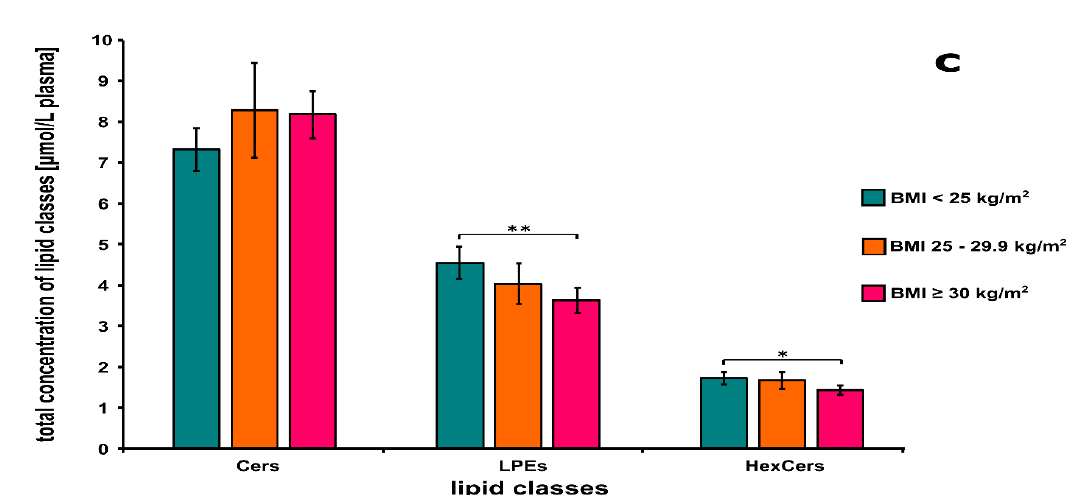
Figure 3. Changes in the average concentration (panels a – c ) of lipid classes in association with body mass index (BMI) categories. Lipids were extracted from plasma samples of normal weight (BMI < 25 kg/m 2 ), overweight (BMI: 25– 29.9 kg/m 2 ), and obese (BMI ≥ 30 kg/m 2 ) subjects. The levels of lipid classes were measured by a high-performance liquid chromatography coupled with electrospray ionization tandem mass spectrometry (HPLC ESI-MS-MS) using the Lipidyzer platform as described in the Material and Methods section. Abbreviations: CEs = cholesterolesters, Cers = ceramides, DGs = diacylglycerols, FAs = fatty acids, HexCers = hexosylceramides, LPCs = lysophosphatidylcholines, LPEs = lysophosphatidylethanolamines, PCs = phosphatidylcholines, Pes = phosphatidylethanolamines, SMs = sphingomyelins, TGs = triacylglycerols. * p < 0.05; ** p < 0.01; *** p < 0.001.